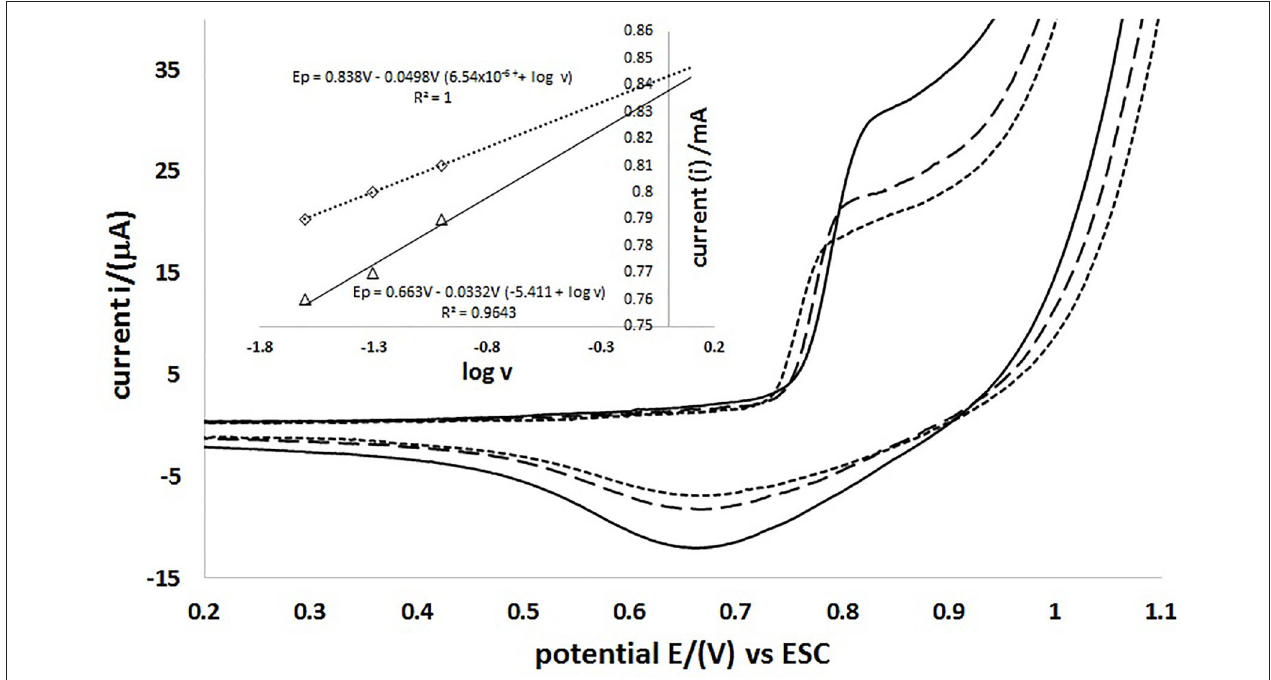
FIGURE 7 | MCPE cyclic voltammetry at different scanning rates vs. SCE 100 mVs − 1 (—), 50 mVs − 1 (- - -) and 25 mVs − 1 ( · · · ). The insert shows the current dependency to the logarithm of scan